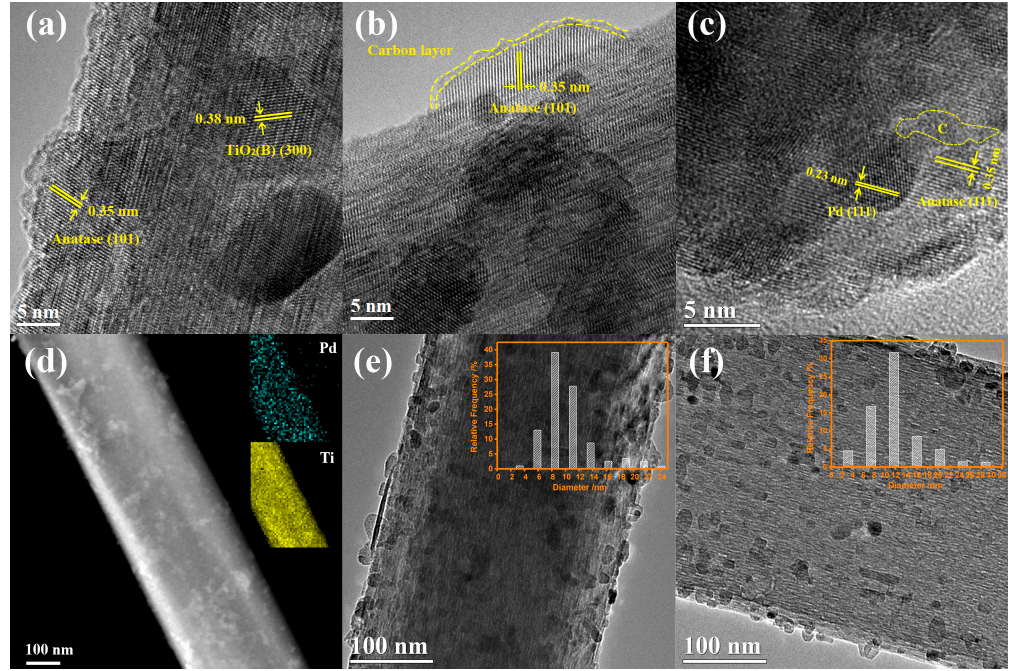
Figure 3. TEM images of the samples: ( a – e ) Pd/C-mb-TiO 2 and ( f ) Pd/mb-TiO 2 ; ( d ) Elemental Pd and Ti maps of Pd/C-mb-TiO 2 .